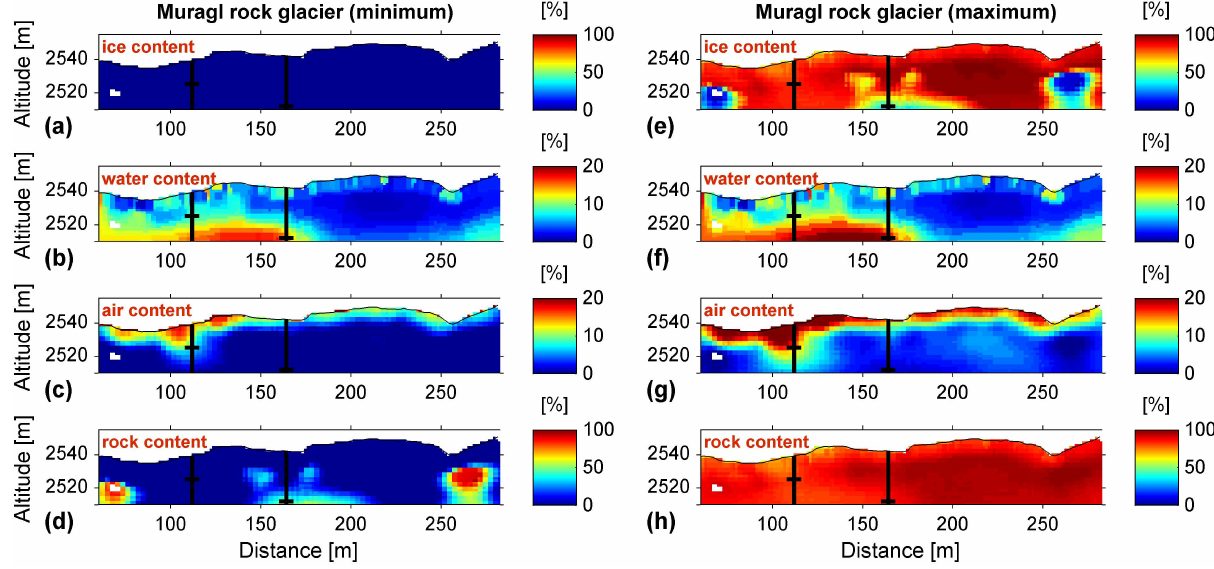
Fig. 10. General 4-phase model results for Muragl rock glacier. The locations of the two boreholes are indicated by black vertical lines – the depth of the water table by the black horizontal lines. (Left) Solutions with minimum values and (right) solutions with maximum values. Note, that the range of the colour scales is